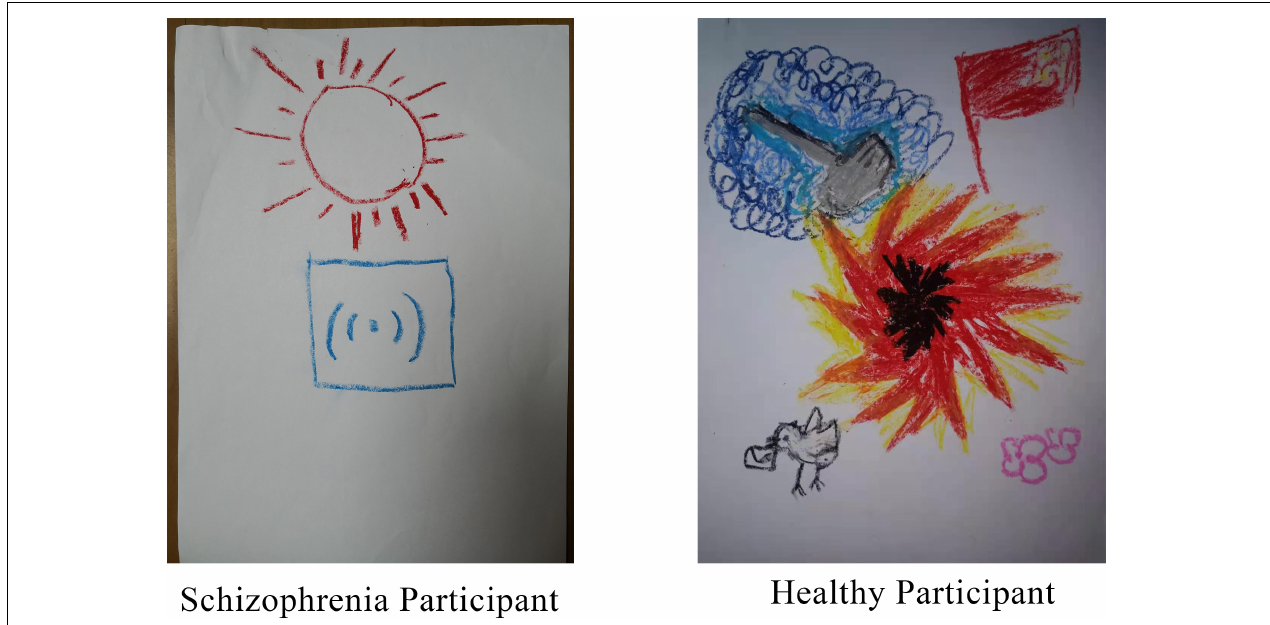
FIGURE 6 | Specific examples of drawings from participants in the schizophrenia group (left) and the healthy group (right).